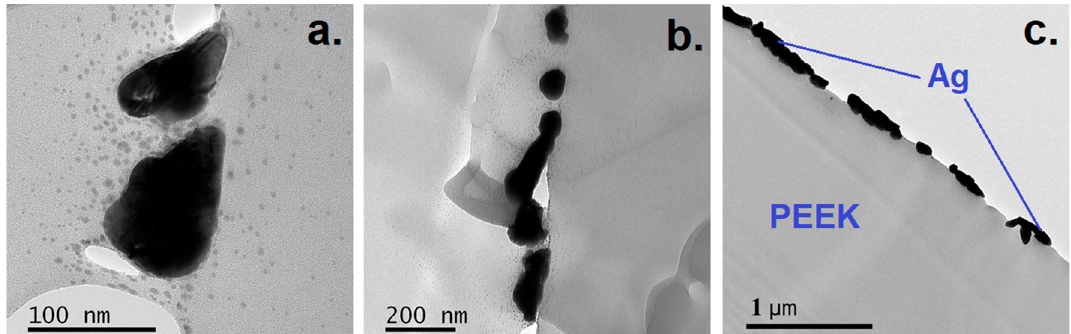
Figure 5. TEM images of the sample PEEK/Ag0.12 with two layers. ( a ) 100 nm; ( b ) 200 nm; ( c ) 1 µ m.